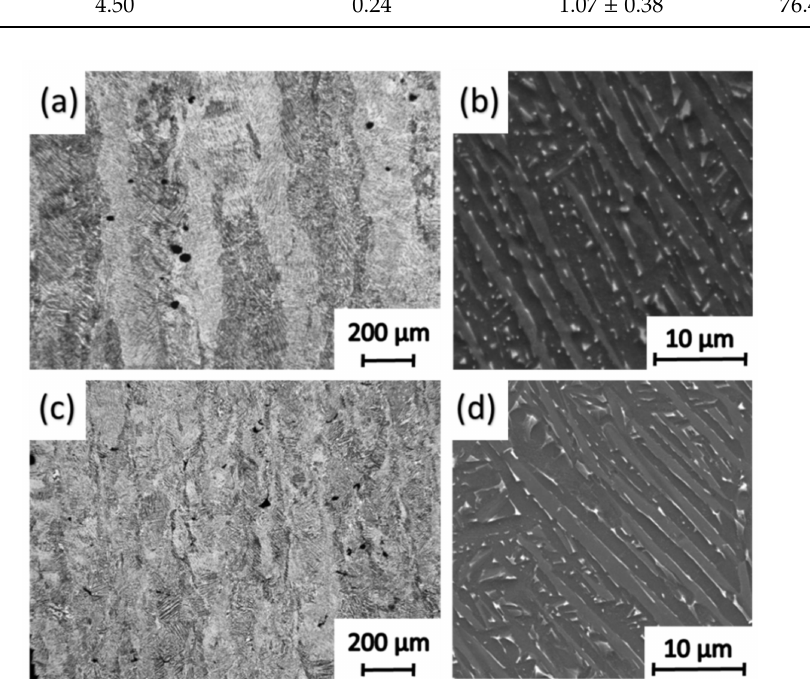
Figure 10. Microstructure of the stress relieved flat SLM-processed specimens built in the ZXY orientation: ( a ) thickness of 1 mm, ( b ) detail of specimen with thickness of 1 mm, ( c ) thickness of 3 mm and ( d ) detail of specimen with thickness of 3